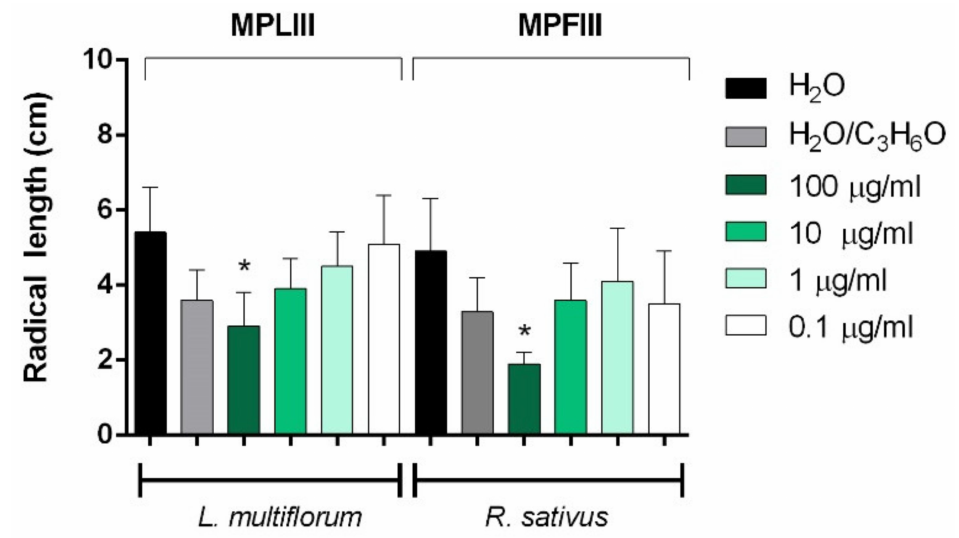
Figure 9. Phytotoxic activity of M. pulegium leaves (MPLIII) and flowers (MPFIII) EOs against the radical elongation of L. multiflorum and R. sativus 120 h after sowing. Results are the mean of three experiments ± standard deviation. * p < 0.05compared with control (ANOVA followed by Dunnett’s multiple comparison